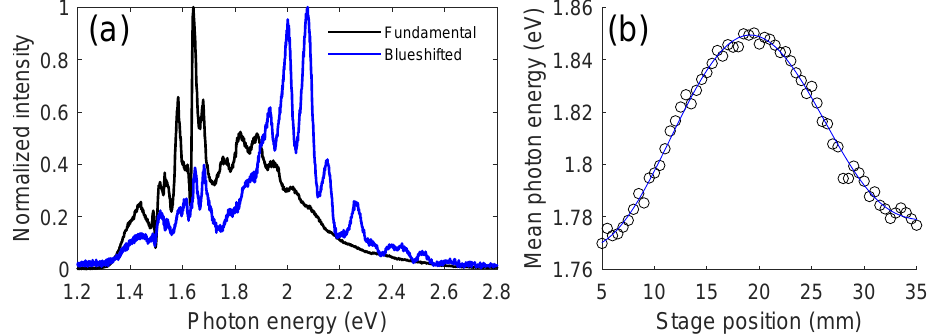
Figure 1. ( a ) Schematic experimental setup. A gas cell for THG is housed in a small chamber, nested inside a larger main chamber. ( b ) Geometry of the laser beam near the focus. z 0 represents the gas cell position. A negative z 0 value means the gas cell is positioned before the laser focus and vice versa. The laser focus is at z 0 = 0 mm.